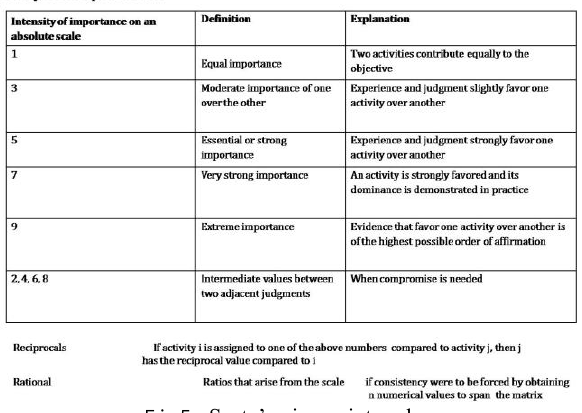
Fig 5: Saaty’s nine point